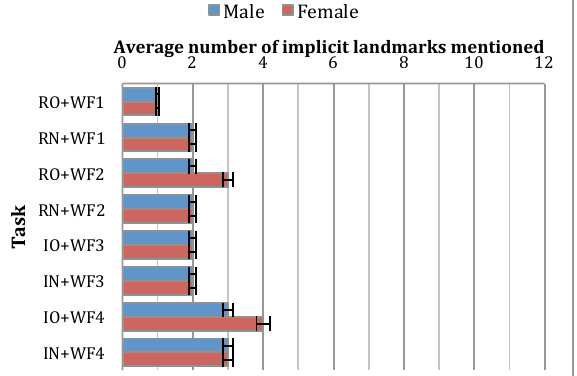
Figure 6. Average number of implicit landmarks mentioned